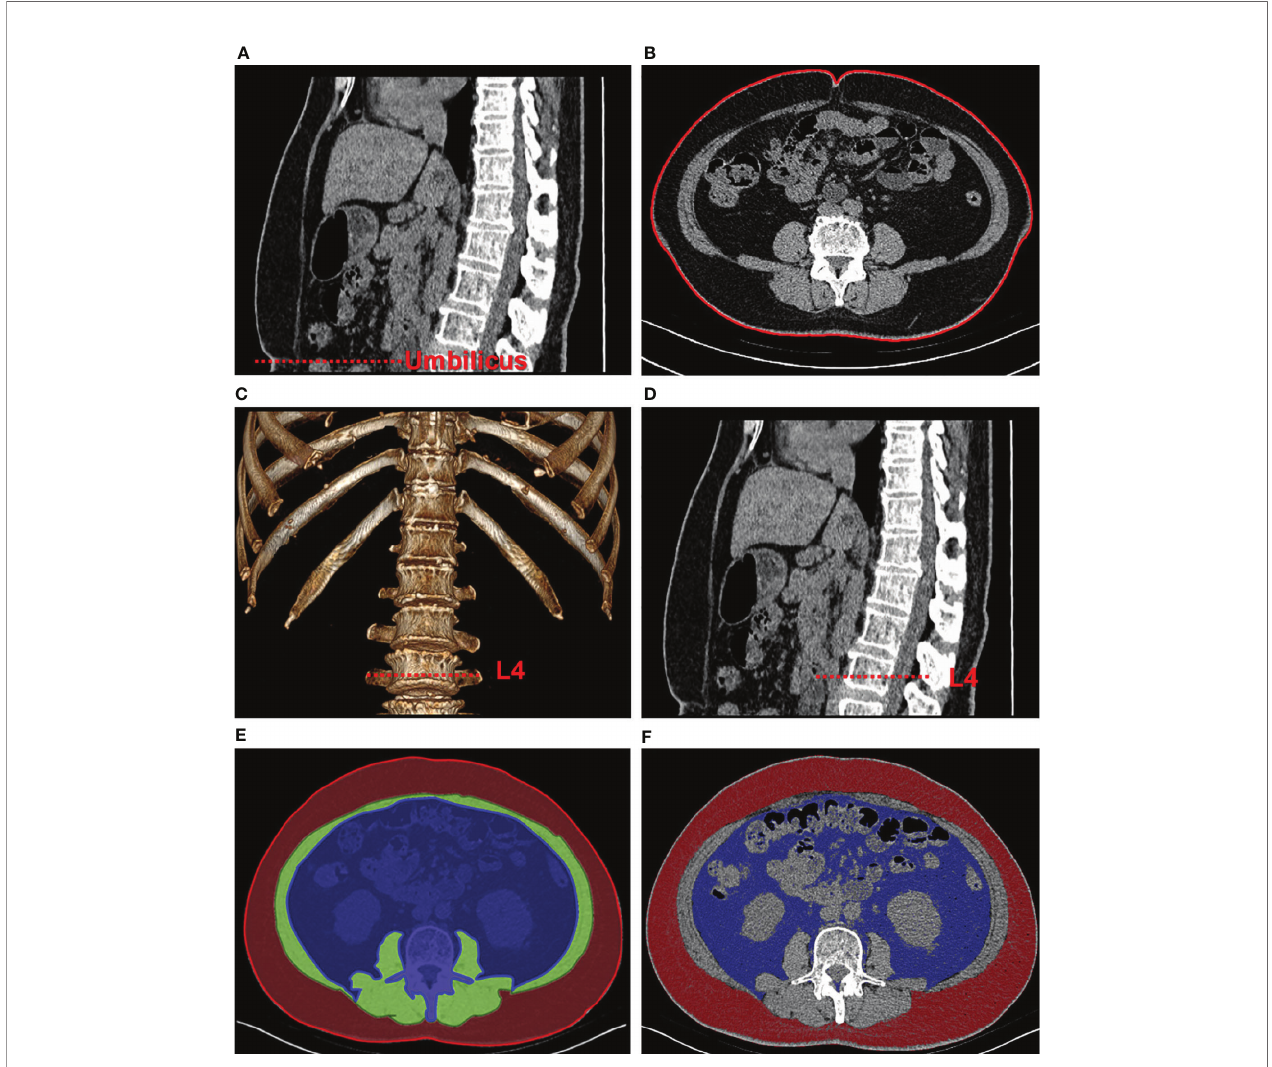
FIGURE 1 | Schematic of abdominal adipose tissue quanti fi cation using computed tomographic images. The sagittal plane (A) was used to locate the umbilical area, and one of the corresponding transverse planes (B) was selected to measure waist circumference. Then, volume rendering (C) was used to locate the L4 area (D) . The regions of interest of visceral fat (blue), muscular layer (green), and subcutaneous fat (red) were circled in one of the transverse planes (E) . Quanti fi cation of the fat areas was completed through threshold segmentation (F)